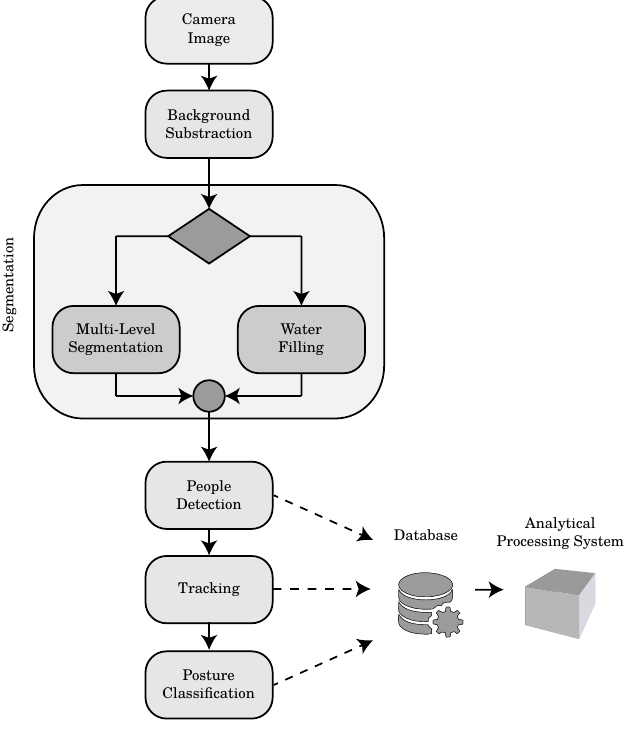
Figure 16. Block diagram of the implemented